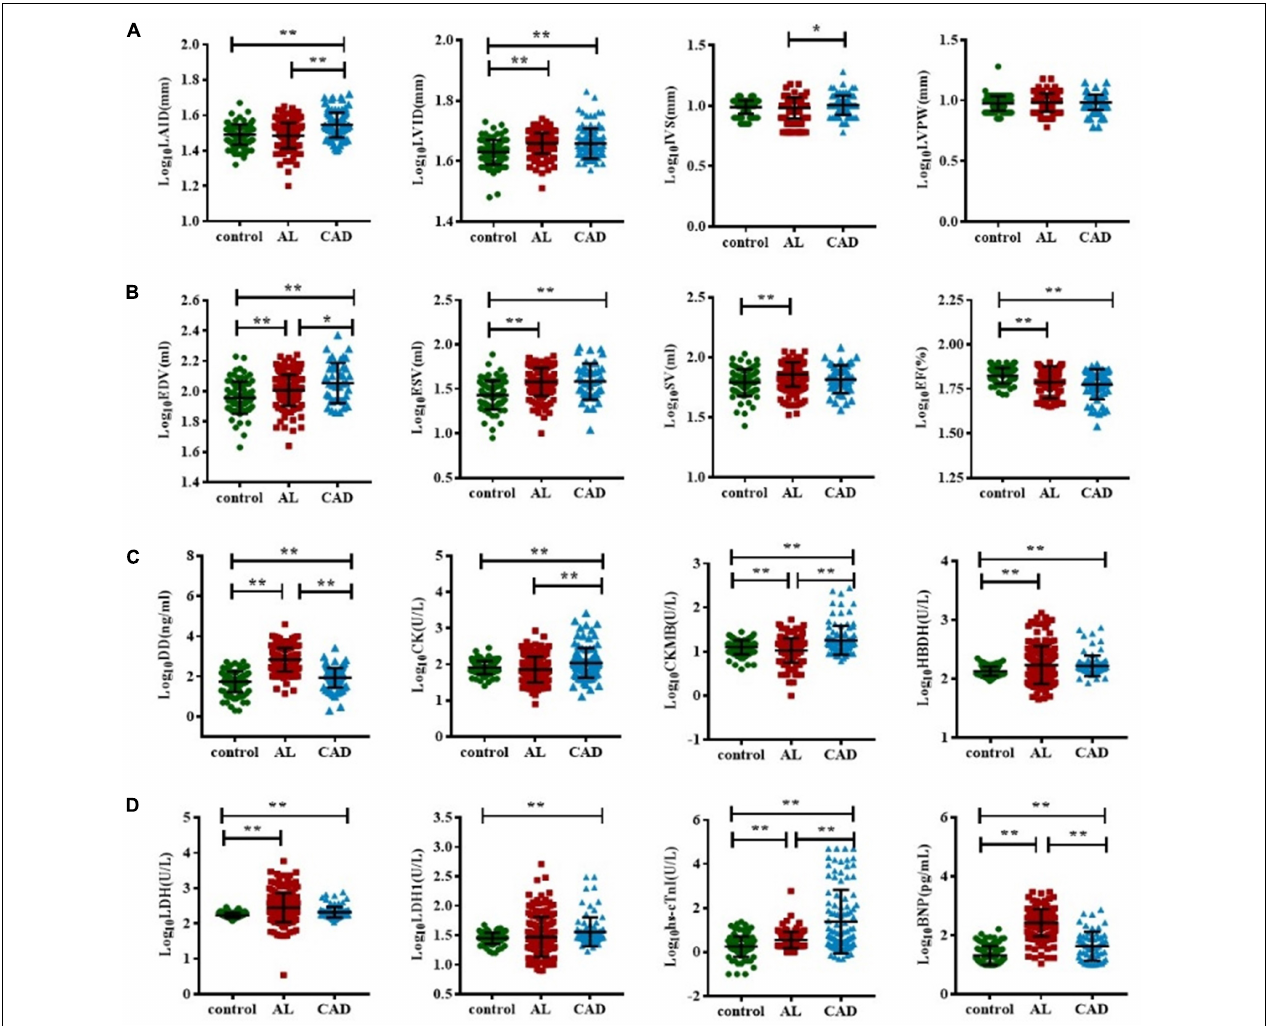
FIGURE 2 | Comparison of cardiac function impairment indicators in acute leukemia, coronary artery disease, and control group patients. The T test was used to compare the myocardial enzyme and echocardiography indexes of the three group (A–D) . (*represents p < 0.05, ** represents p < 0.01). BNP, B-type natriuretic peptide; CK, creatine kinase; CK-MB, creatine kinase myocardial band; DD, D-dimer; EDV, end-diastolic volume; ESV, end-systolic volume; EF, ejection fraction; hs-cTnI, highly sensitive troponin-I; HBDH, hydroxybutyrate dehydrogenase; IVS, interventricular septal; LVPW, left ventricular posterior wall; LDH, lactate dehydrogenase; LAID, left atrial internal diameter; LVID, left ventricular internal diameter; SV, stroke